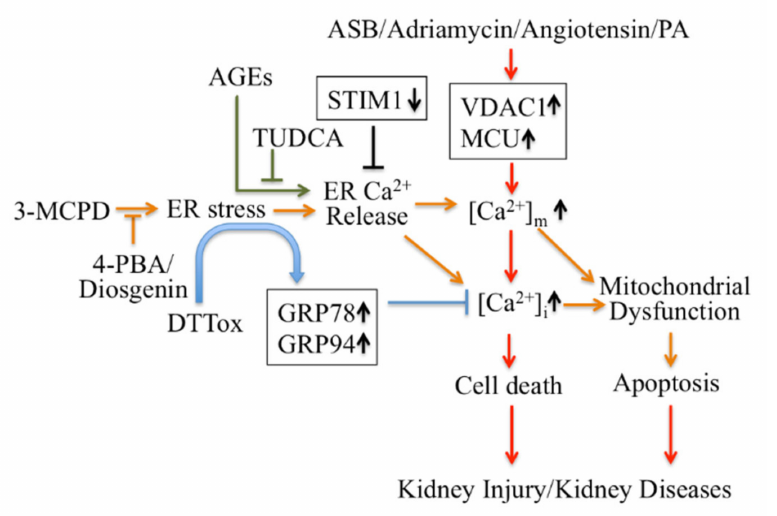
Figure 1. Targeting Ca 2+ signaling regulating cell death for therapy of kidney diseases.